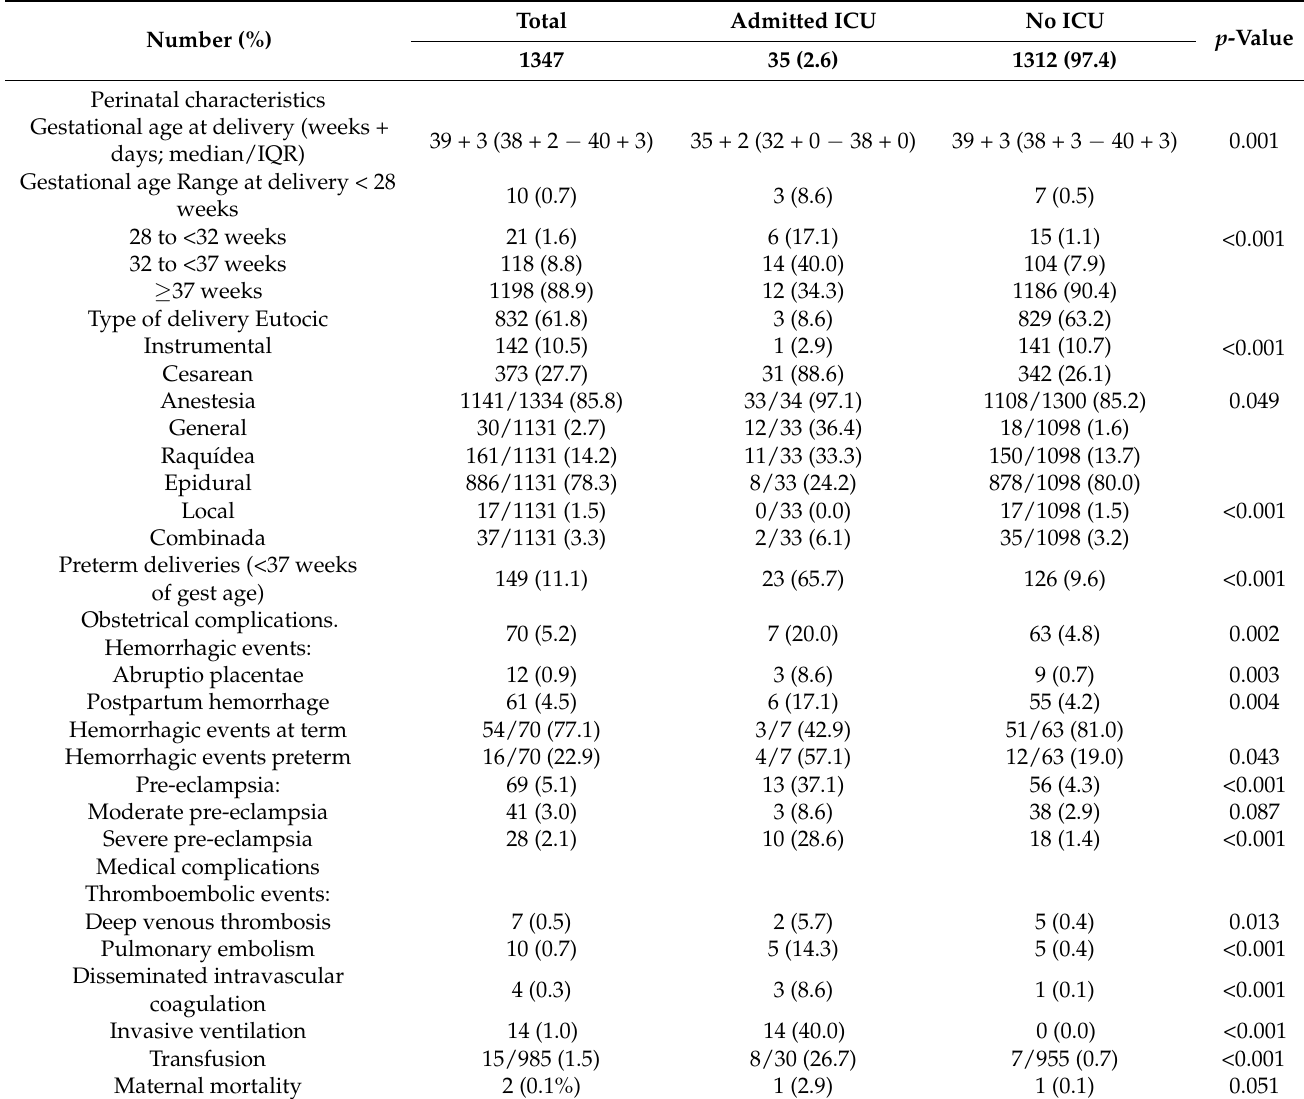
Table 2. Perinatal characteristics and complications of the study participants (n =